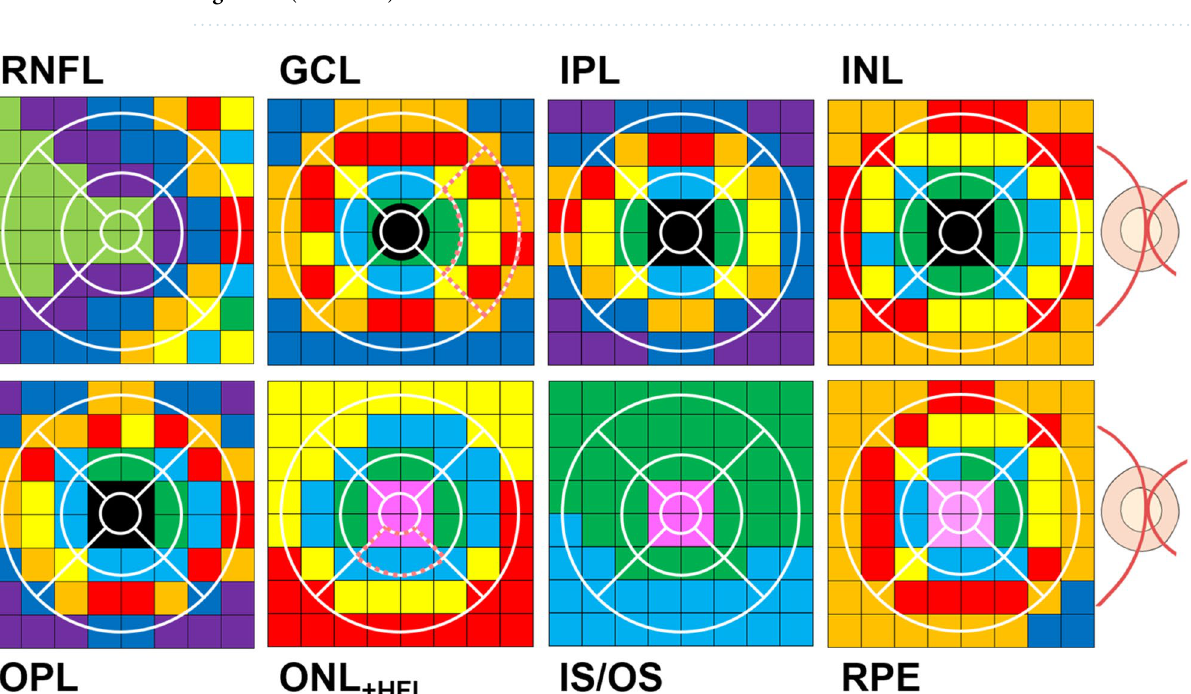
Figure 5. An illustrative comparison between spatial cluster topographies (in right eye format) and the ETDRS sectors. Note how there are multiple different clusters and hence multiple different average thicknesses and rates of age-related change within each ETDRS sector. Dotted markings highlight the GCL outer-ring nasal and ONL +HFL inner-ring inferior ETDRS sectors, used for the quantitative examples